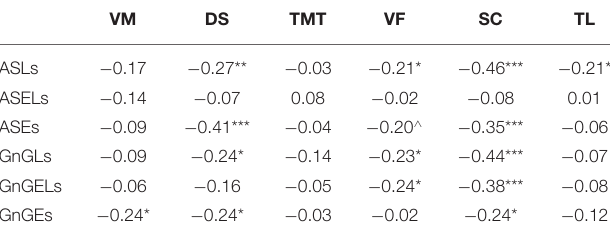
TABLE 7 | Correlation of cognitive and oculomotor